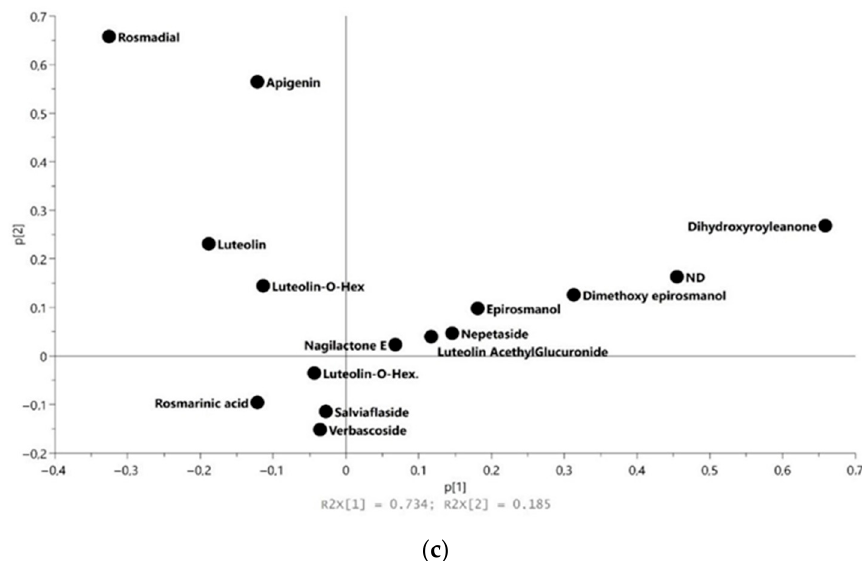
Figure 1. ( a ) PCA score plot based on UHPLC − MS data showing separation of C. amboinicus cultivated in Indonesia (CI1 and CI2) and leaves (CPL), flowers (CPF), stems (CPS) and twigs (CPT) from C. amboinicus cultivated in Poland with their respective 95% confidence regions. The explained variances are shown at the bottom; ( b ) the corresponding loadings scatter plot showing the compounds that are correlated to separation in scores plot; ( c ) the corresponding loadings scatter plot showing only the compounds that are correlated and most responsive to separation in scores plot.